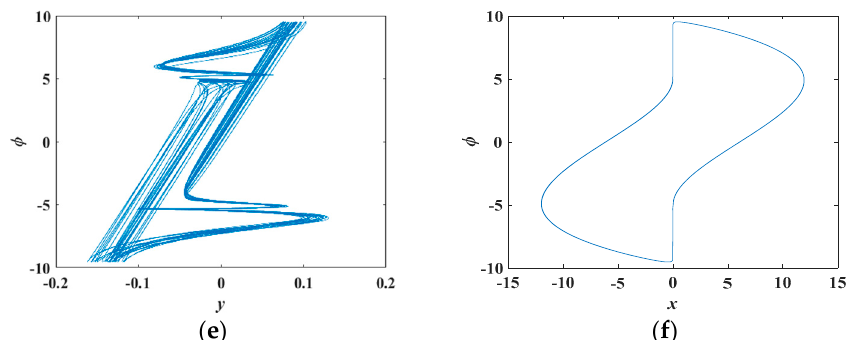
Figure 6. Phase diagrams of the novel chaotic attractor of the AM-based oscillatory circuit: ( a ) on the ( x , y , z ) space; ( b ) on the ( y, z , φ ) space; ( c ) on the ( y , z ) plane; ( d ) on the ( x , y ) plane; ( e ) on the ( y, φ ) plane; ( f ) on the ( x , φ ) plane.